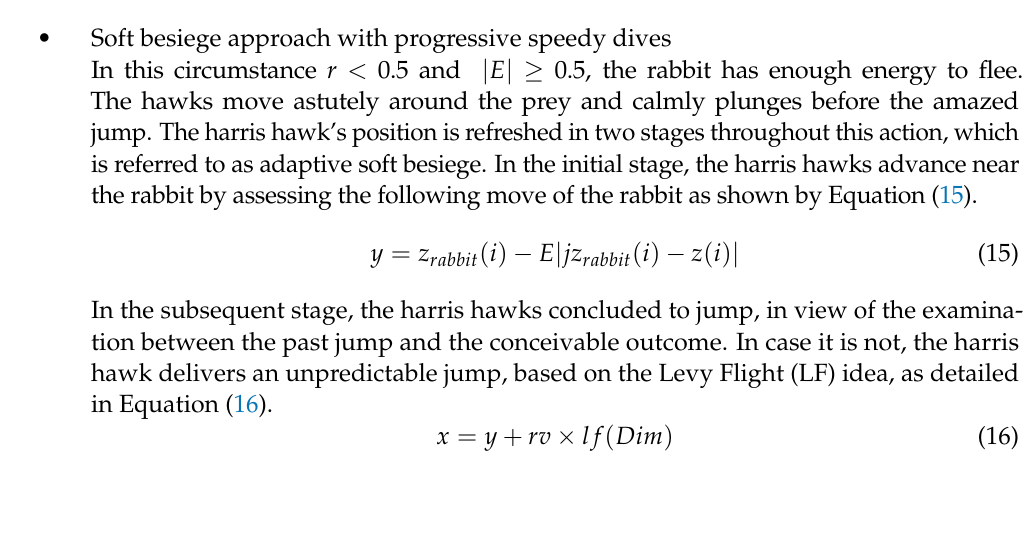
Figure 5. In the scenario of a hard besiege, a sample of overall